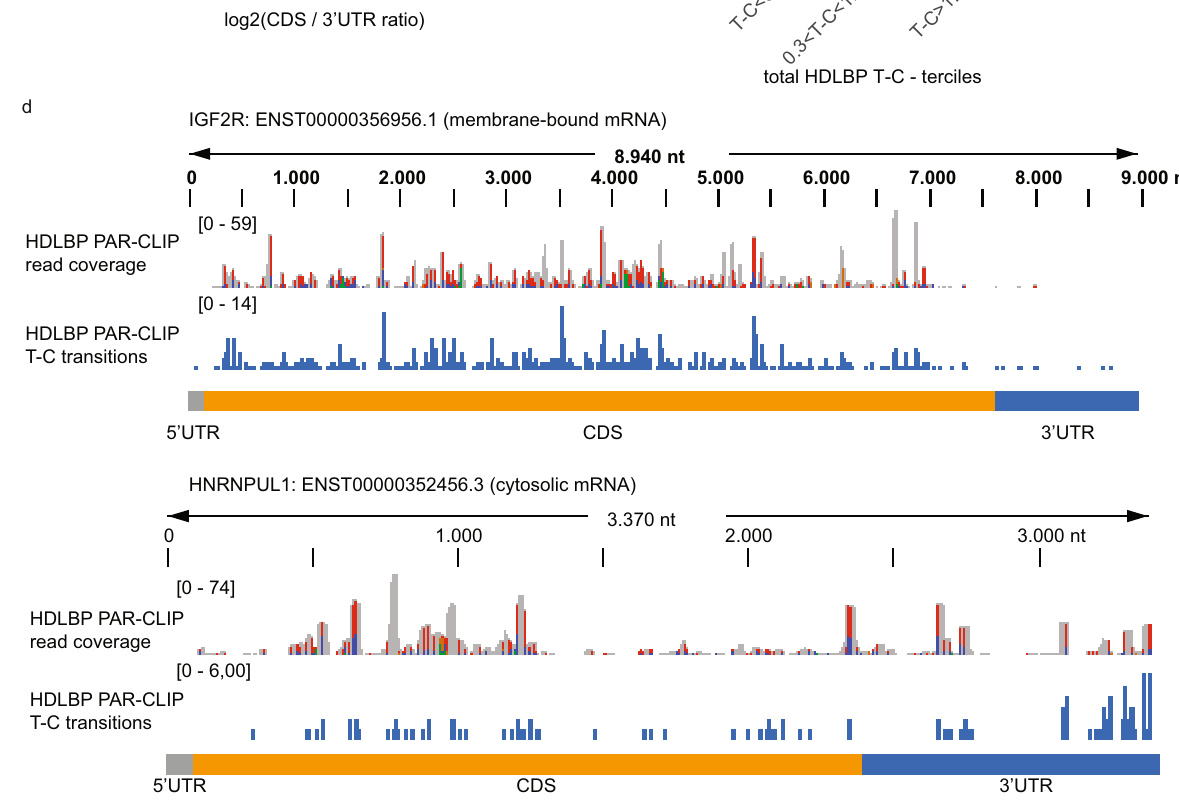
To understand the impact of multivalent interactions on HDLBP binding af fi nity, we next performed the in vitro HDLBP binding assay using RNA molecules with different numbers of bound four-mer motifs within a longer (34 nt) sequence (Fig.